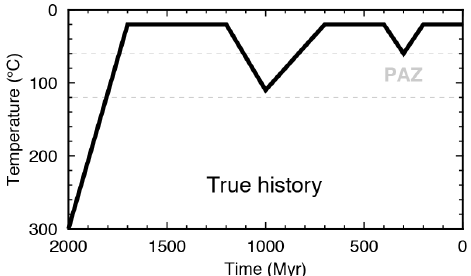
Figure 1. Thermal history used to predict synthetic AFT and AHe data. This t – T path is referred to as the “true” thermal history throughout this paper. The predicted synthetic data were then used as input for QTQt to recover the thermal history through inverse modelling. PAZ: partial annealing zone for fission